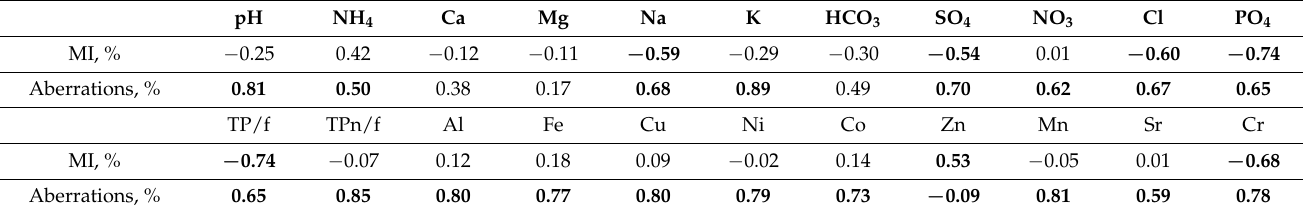
Table 3. MI and aberrant cell percentage correlation dependencies on pollutant